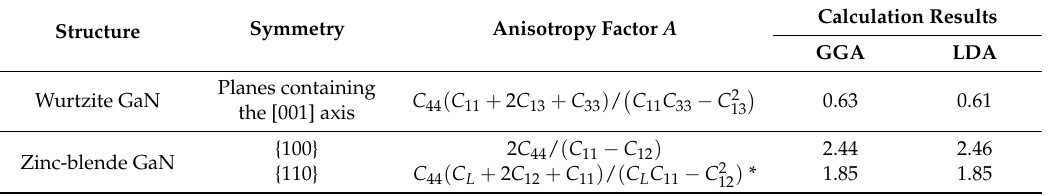
Table 5. Anisotropy factor A